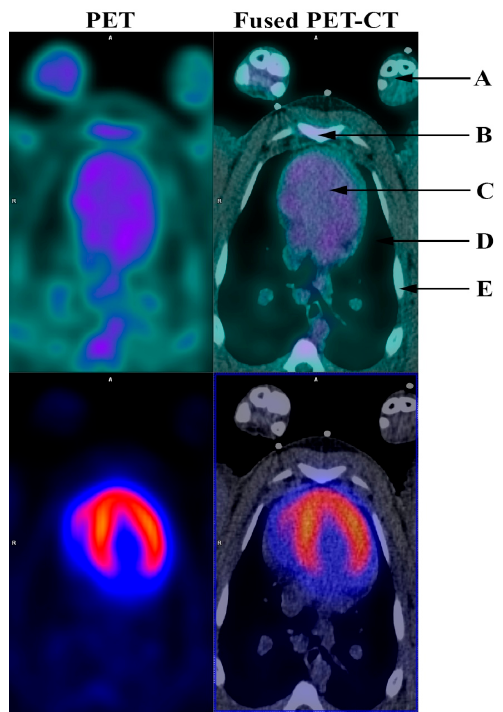
Figure 1. Angiogenesis PET (RGD PET) (top row) and 82 Rb dipyridamole stress PET (bottom